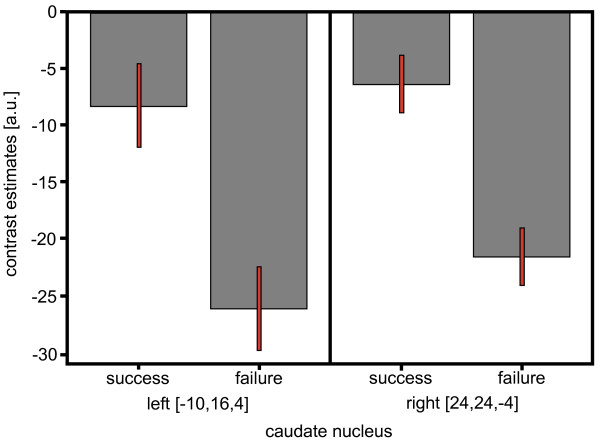
Contrast estimates at the left and right caudate nucleus with 90% confidence interval. The figure reflects the contrast between baseline and the success or failure events, respectively. Note that even after success event rather a trend to deactivation of the reward system can be observed.